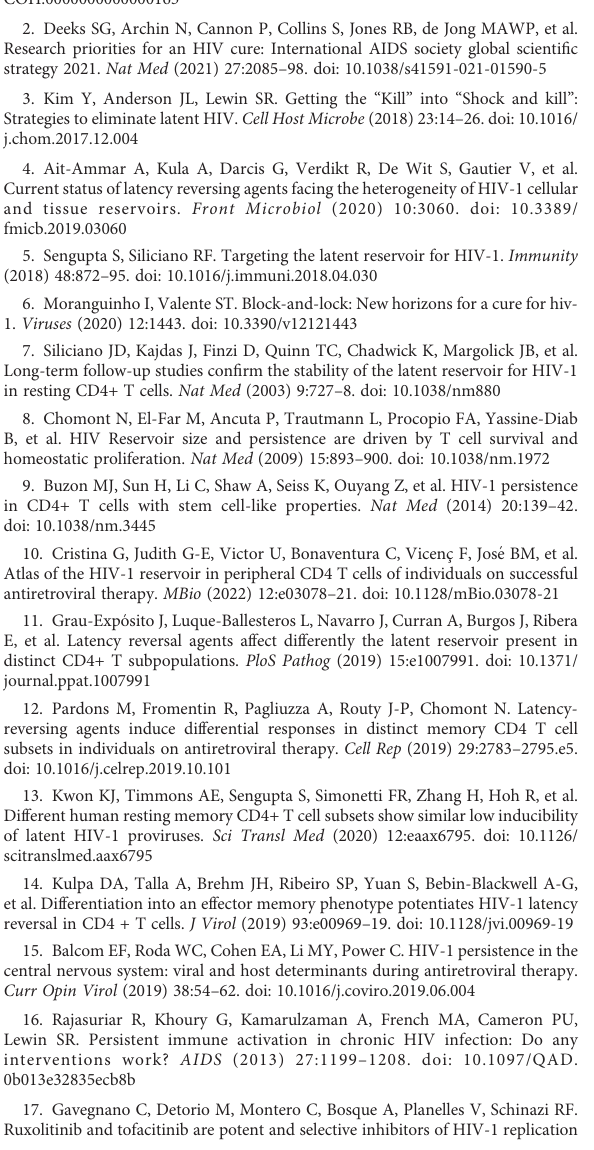
expression was measured by a luciferase-based assay. (F) Relative IRF7 mRNA expression of non-transfected TZM-bl cells treated with JAK2i for SUPPLEMENTARY TABLE 1 Immunological and virological characteristics of study participants at the time of cell sample collection. * ABC, abacavir; COBI, cobicistat; DRV, darunavir; DTG, dolutegravir; FTC, emtricitabine; RAL, raltegravir; TAF, tenofovir alafenamide; 3TC,